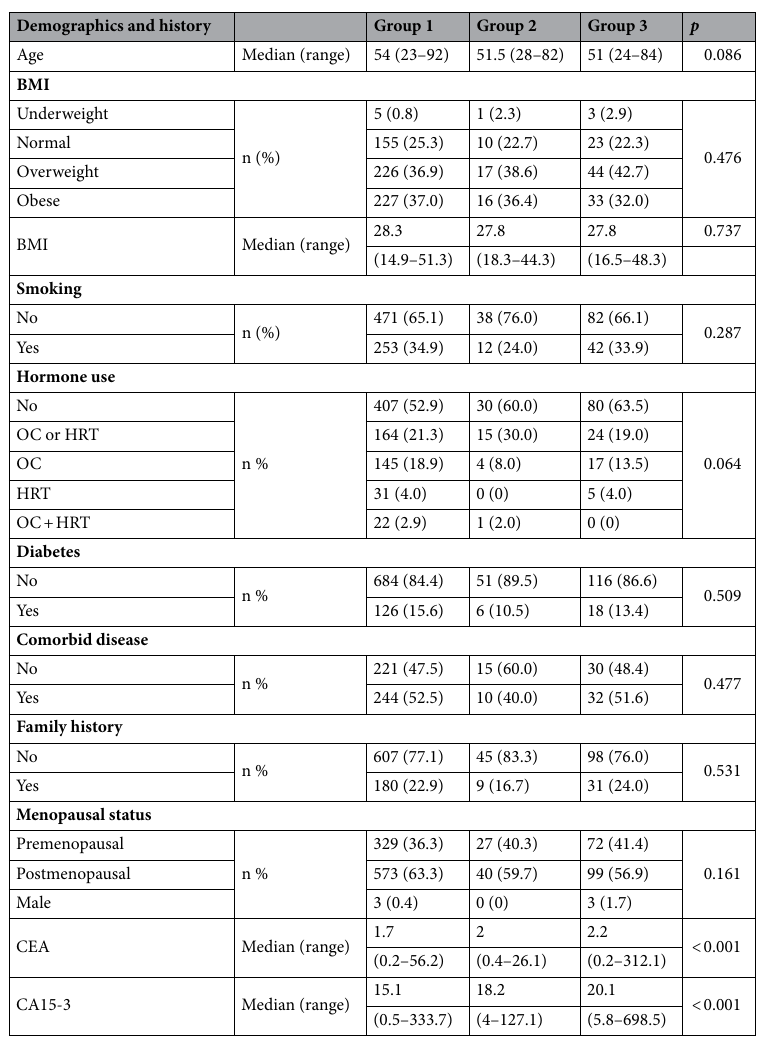
Table 1. Demographics and history. BMI body mass index, OC oral contraceptives, HRT hormone replacement